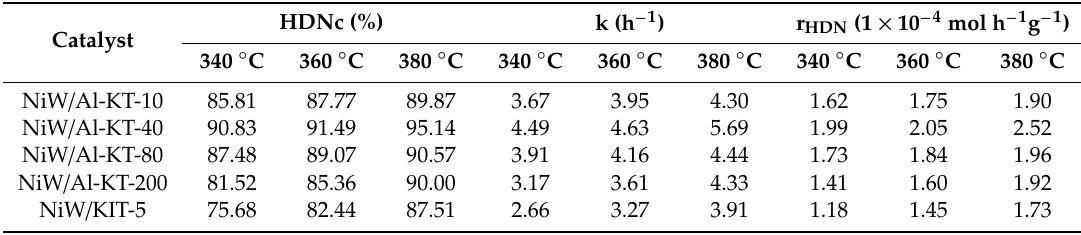
Table 5. The hydrodenitrogenation conversion (HDNC) of quinoline on the NiW / Al-KT-X (X = 200, 80, 40, 10) and the NiW / KIT-5